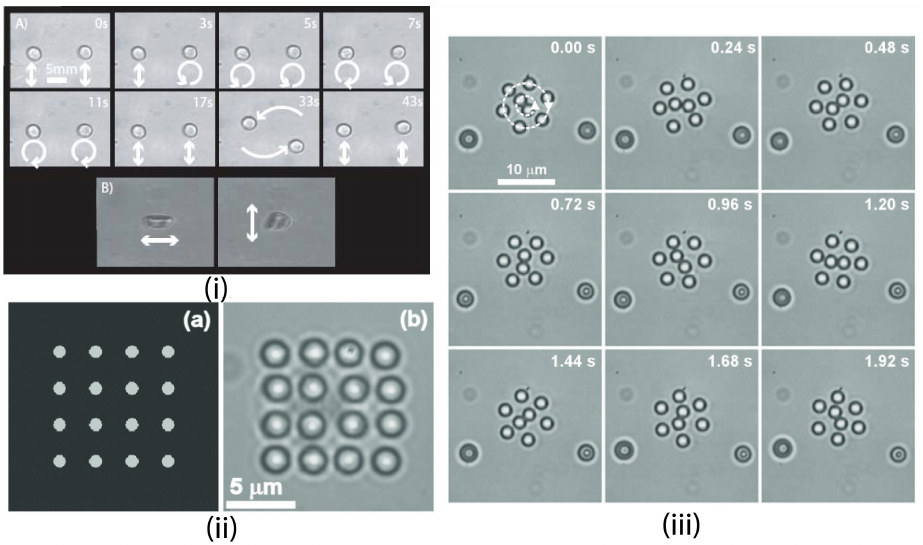
Figure 6. Multiple particle trapping using a spatial light modulator (SLM) ( i ) ( A ) Two birefringent vaterite crystals rotated individually in a holographic optical tweezers image sequence ( B ) change in polarization state causes a change in particle orientation [145]. Copyright 2008 Optical Society of America. ( ii ) ( a ) greyscale depiction of the phase pattern directed on the SLM to generate a 4 by 4 optical trap and ( b ) efficient capture of 16 particles (2 µ m in diameter). ( iii ) dynamic rotation of eight polystyrene beads (2 µ m in diameter) trapped in phase-contrast optical traps. Outer six particles revolve 1/8 of a full rotation clockwise, whereas the inner two particles rotate nearly one full rotation counterclockwise [149]. Copyright 2002 Optical Society of America. In accordance with the BOAI